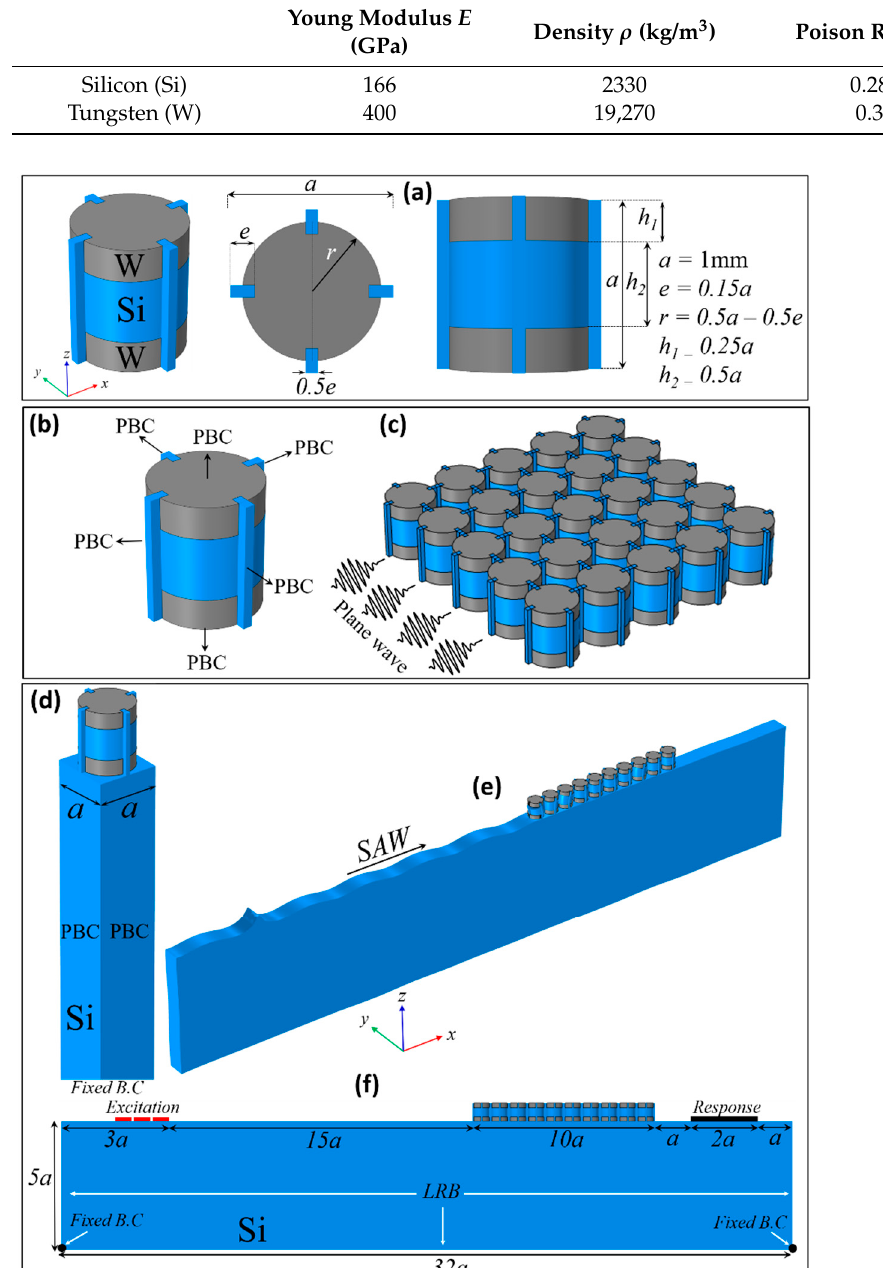
Figure 1. The phononic crystal (PnC) unit cell structure and finite-length model: ( a ) 3D, top and plan view; ( b ) unit cell structure with perfect boundary condition (PBC) applied along all vertical edges and top-bottom; ( c ) supercell model used for plane wave transmission curve study; ( d ) unit cell structure utilized for surface acoustic wave (SAW) band structure study; ( e ) finite-length model with SAW propagation at the surface of semi-infinite half-space can be observed; and ( f ) supercell model adopted for SAW transmission, attenuation and defect analysis.